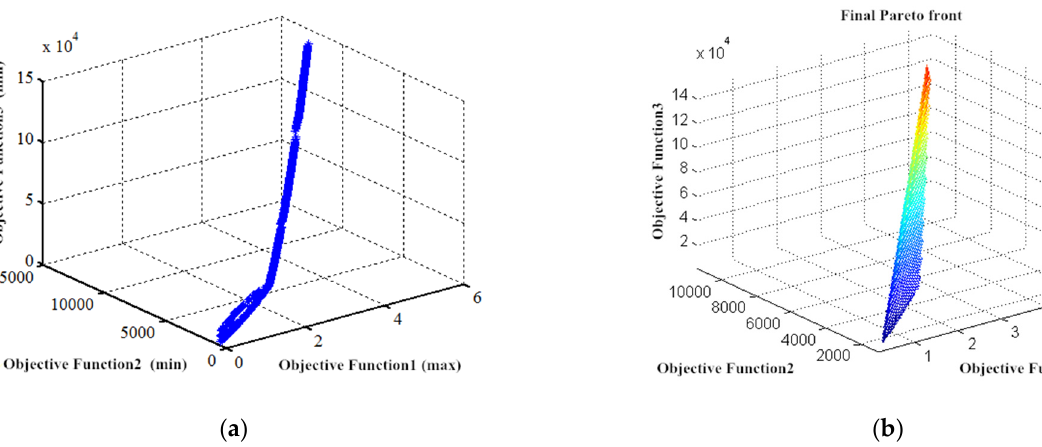
Figure 9. Simulation results of the algorithm. ( a ) Iterative simulation of the objective function; ( b ) The final Pareto frontier based on the improved BM-MOPSO algorithm. A caption on a single line should be centered.